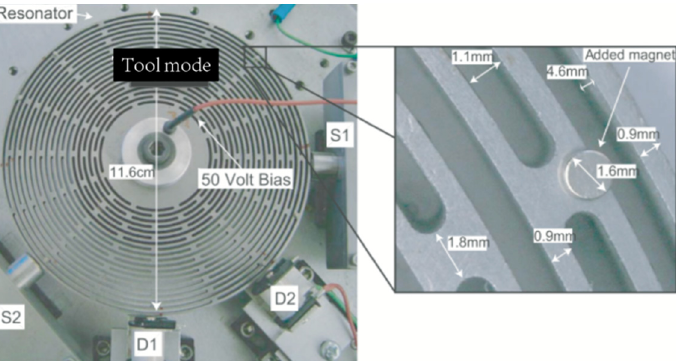
Figure 2. Schematic diagram of the mass perturbation process proposed by UCLA.